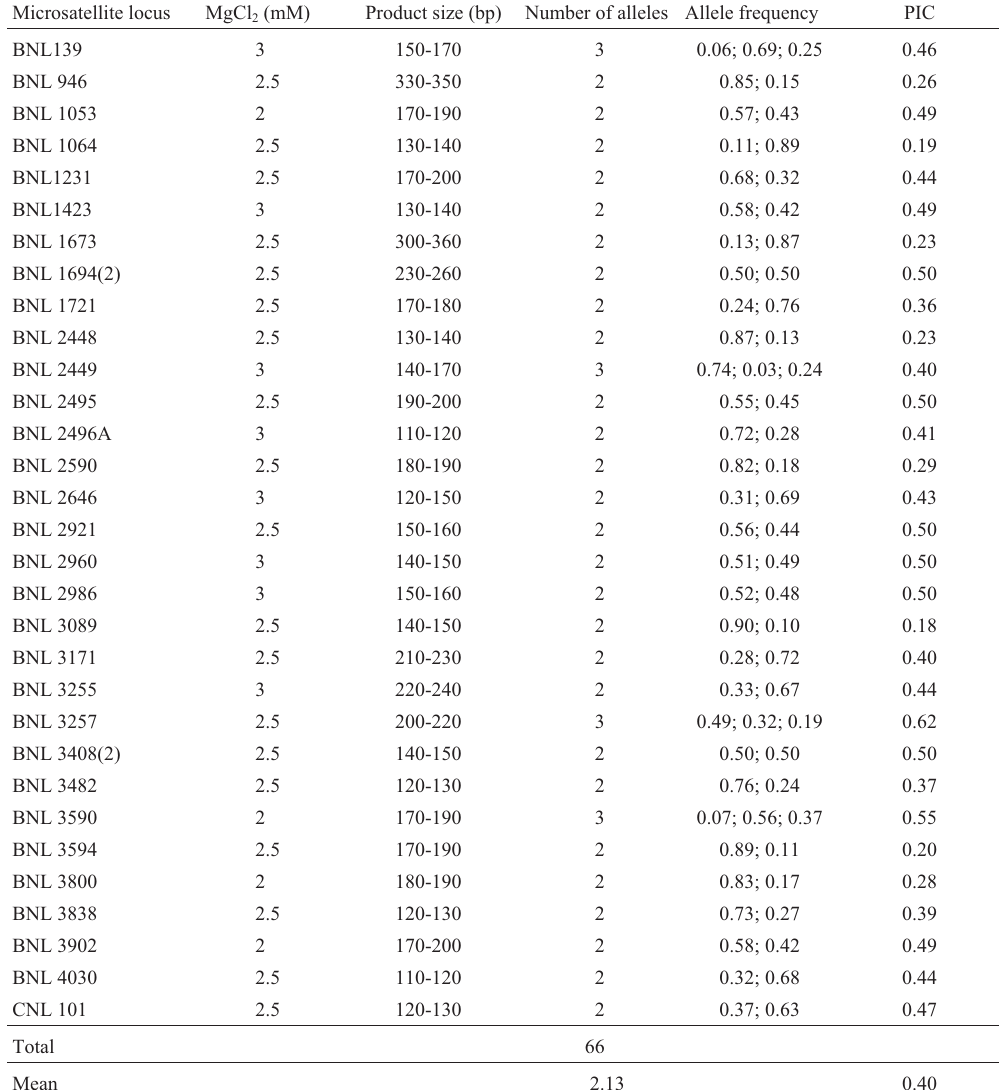
Table 2 - Locus, PCR MgCl 2 concentration and allele product size (bp), number, frequency and polymorphism information content (PIC) for the 31 microsatellite loci used in the analysis of the 53 cotton cultivars shown in Table